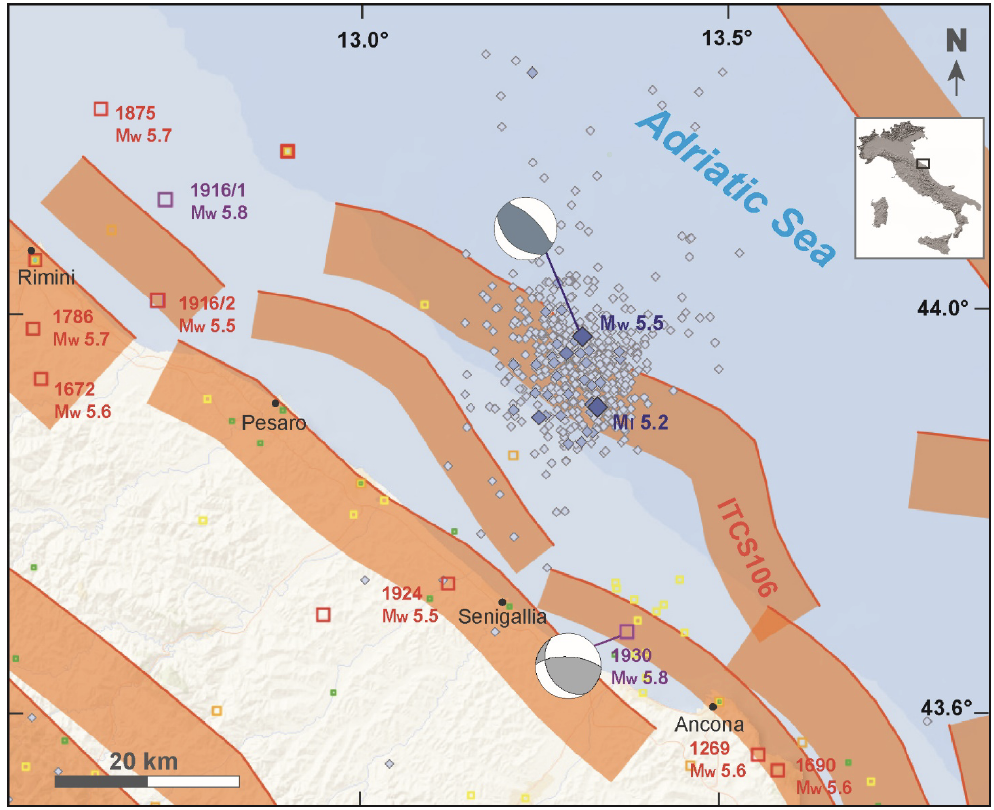
Figure 1. Seismotectonic framework of the northern Marche coastal and offshore area. The seismic sequence from 9 November to 14 February 2023 is shown in light blue (http://terremoti.ingv.it/, accessed on 14 February 2023); historical and instrumental earthquakes from CPTI15 are shown with coloured squares (Rovida et al. [18]), earthquakes with M w ≥ 5.5 are labelled (see Table 1); surface projection of Composite Seismogenic Sources from DISS 3.3.0 are shown with orange ribbons (https://diss.ingv.it, accessed on 14 February 2023; DISS_Working_Group [12]). Fo- cal mechanisms of the 9 November 2022 earthquake and the 30 October 1930 event are from TDMT (http://webservices.ingv.it/webservices/ingv_ws_map/data/tdmt/19591/111604601_15 4_tdmt_reviewer_solution.pdf, accessed on 14 February 2023), and Vannoli et al. [19]),